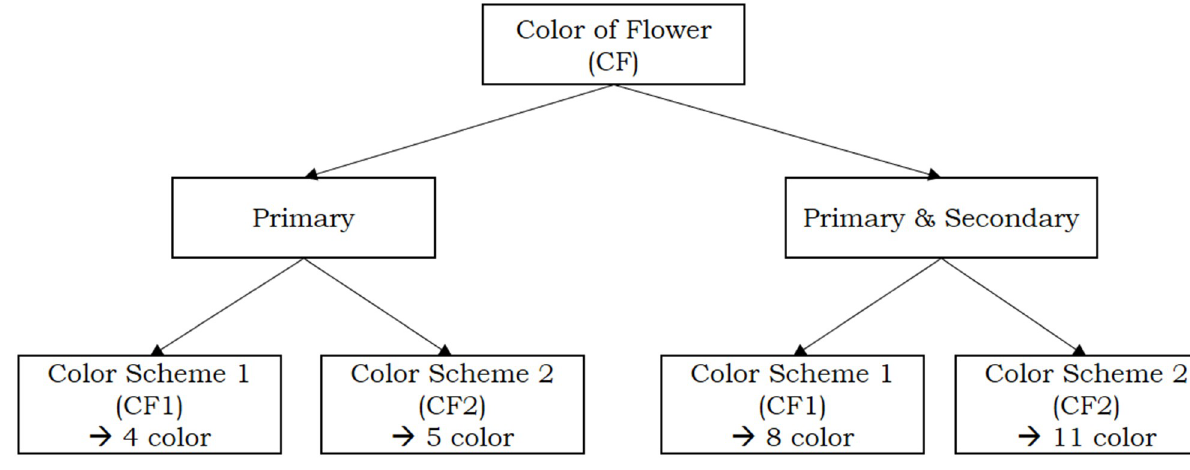
Fig 4. Scenarios for Color of Flower (CF).